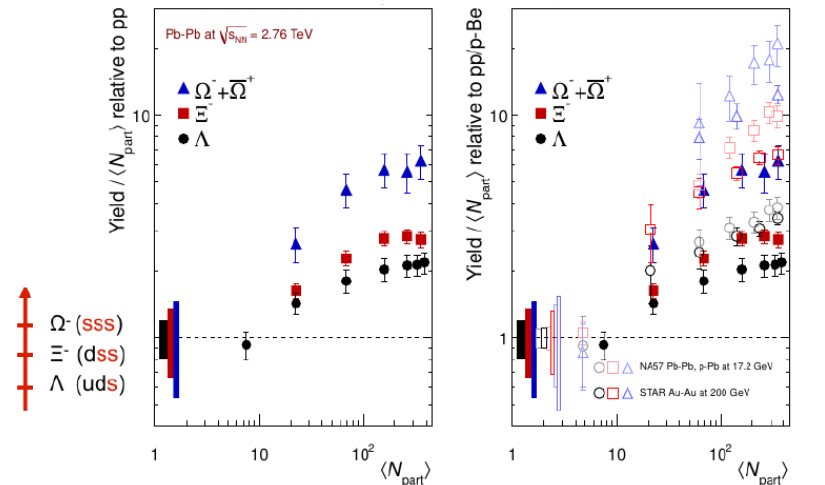
Figure 4. Ratio of strange yields in PbPb collisions with respect to pp collisions as a function of participants. As it is observed in the figure, an enhancement with respect to pp is observed which is larger for Ω (sss) than for Ξ − (dss) and Λ (uds)